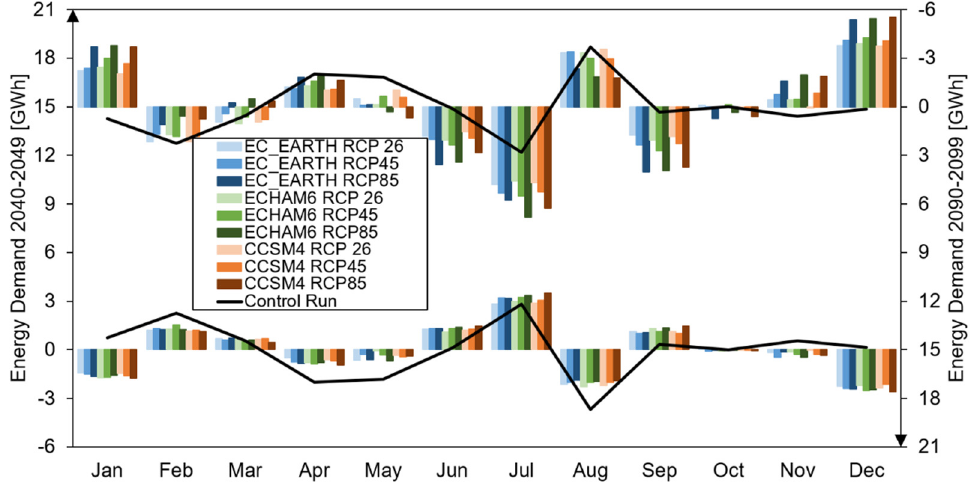
Figure 4. Energy demand monthly projections, climate driven share, compared against the yearly mean, at the mid-century period 2040–2049 (left y-axis) and the end-of-century period 2090–2099 (right y-axis, values upside-down) against the control run period (2005–2013).